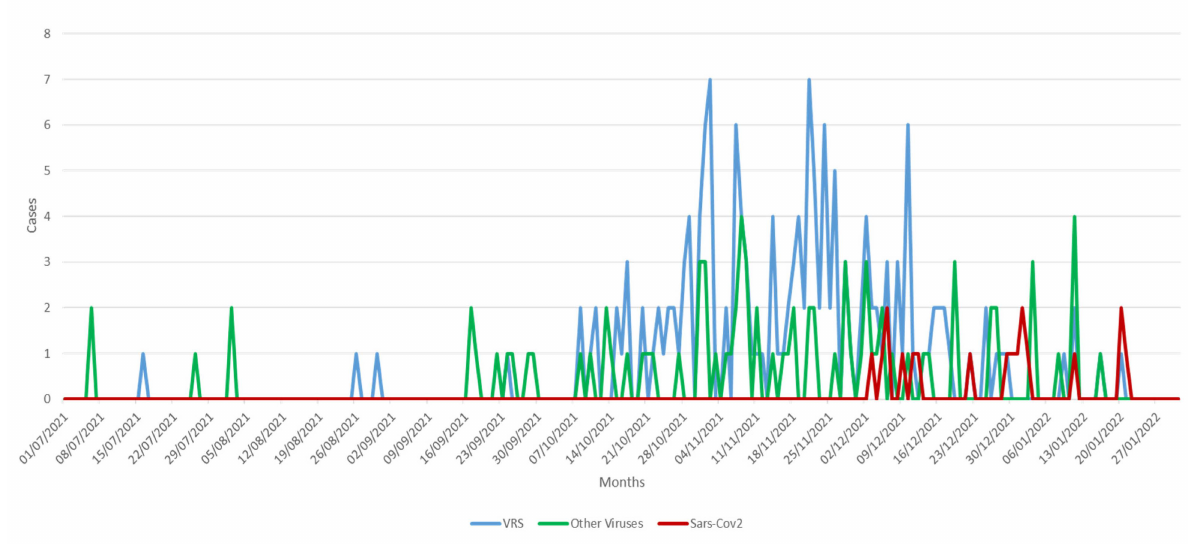
Figure 2. Temporal distribution of cases of bronchiolitis according to the main etiologies.